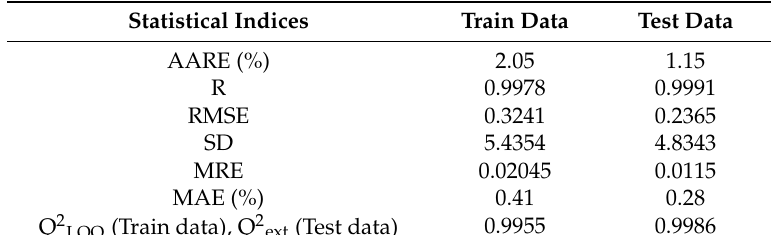
Table 4. Evaluation of SVR-based model based on statistical parameters.